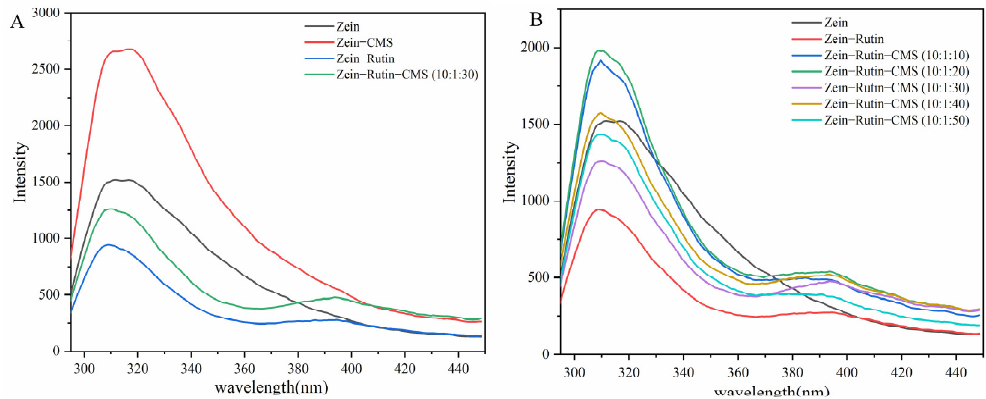
Figure 2. Fluorescence spectroscopy ( A ) Comparison of fluorescence intensity among zein, zein–CMS, zein–RT, and zein–RT–CMS nanoparticles; ( B ) Fluorescence intensity of zein–RT–CMS nanoparticles at different levels of CMS.